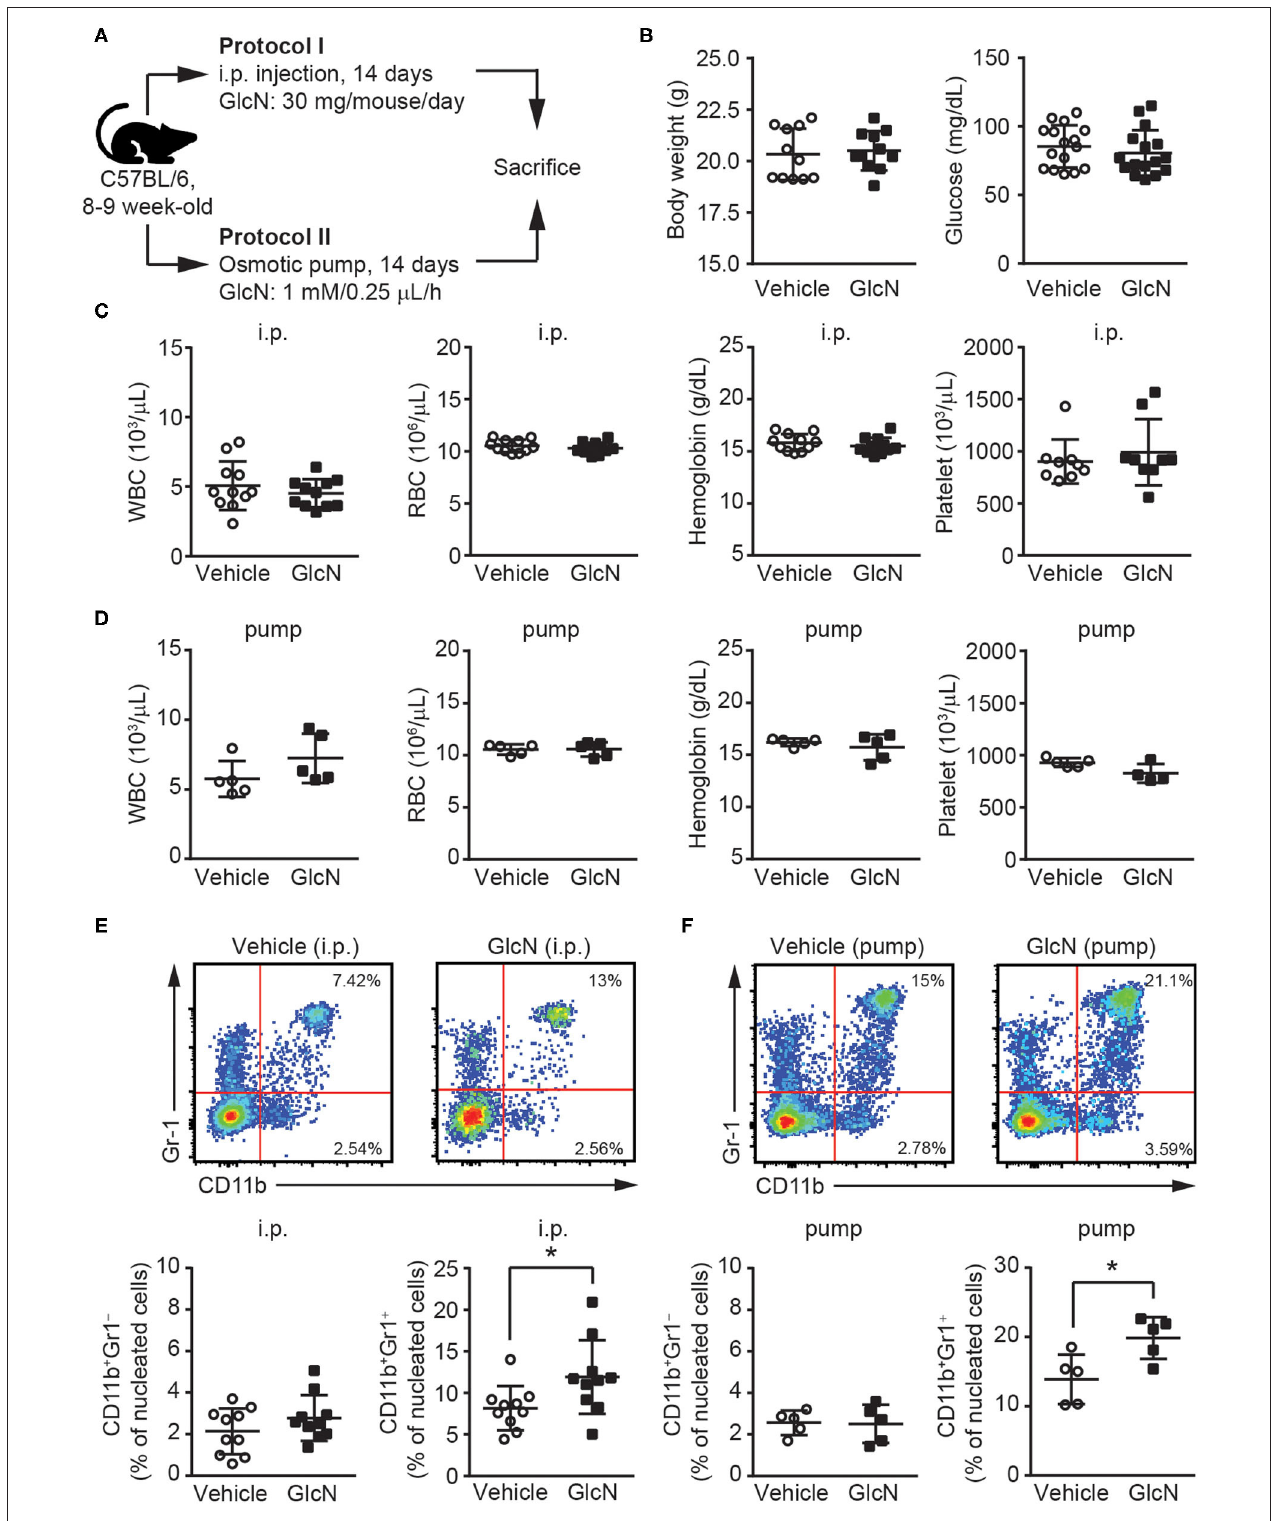
FIGURE 1 | GlcN expands the myeloid compartment of mice. (A) Schematic of GlcN supplementation methods to mice. (B) Body weight and fasting glucose level of GlcN-supplemented mice after 14-day intraperitoneal (i.p.) injection. (C) WBC count, RBC count, hemoglobin level, and platelet count following i.p. treatment. (D) WBC count, RBC count, hemoglobin level, and platelet count following 14-day pump release. (E) Myeloid compartment of peripheral blood from mice given i.p. injection. (F) Myeloid compartment of peripheral blood from osmotic pump-treated mice. The results are presented as the mean ± standard deviation * P < 0.05.